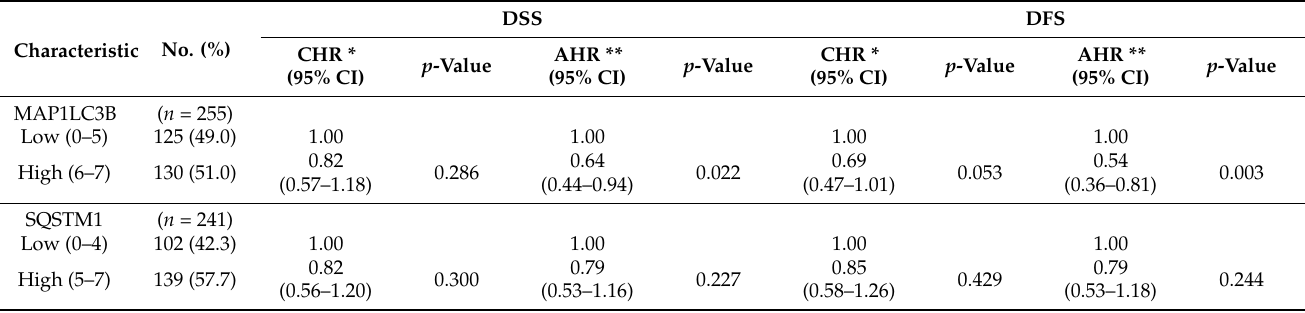
Table 3. Correlation of MAP1LC3B and SQSTM1 expressions with survival in IDC patients.